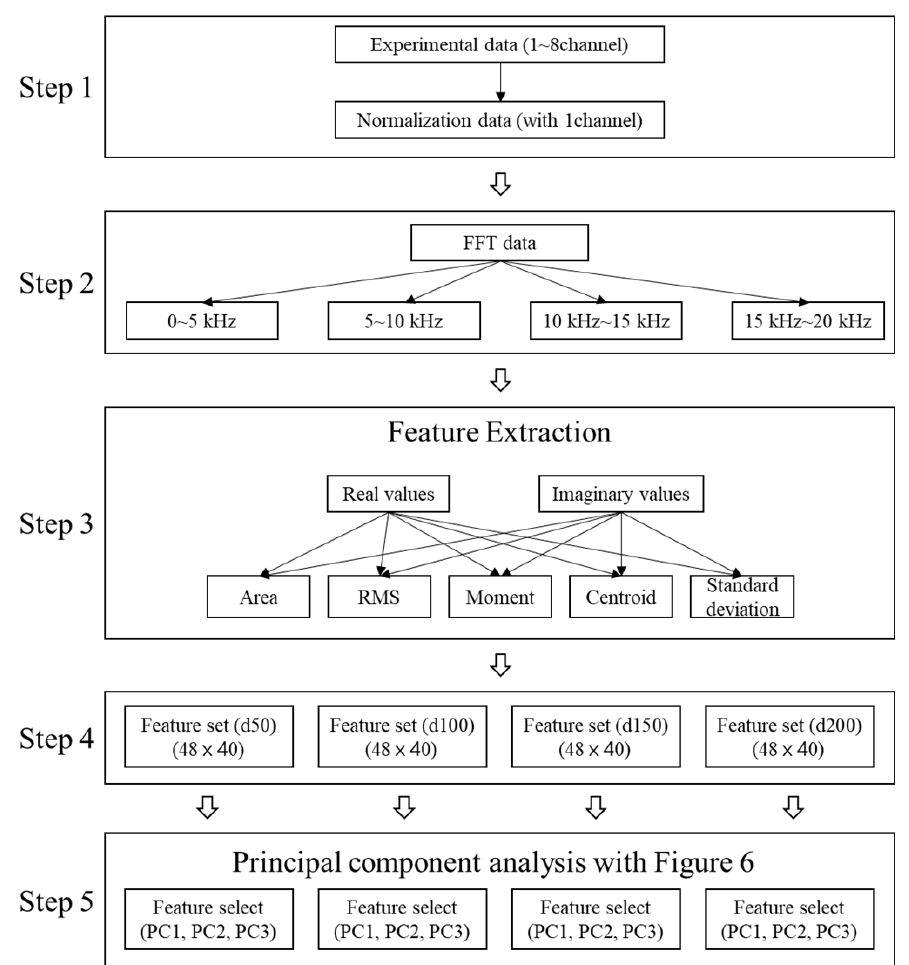
Figure 14. Feature extraction procedure for PCA analysis.